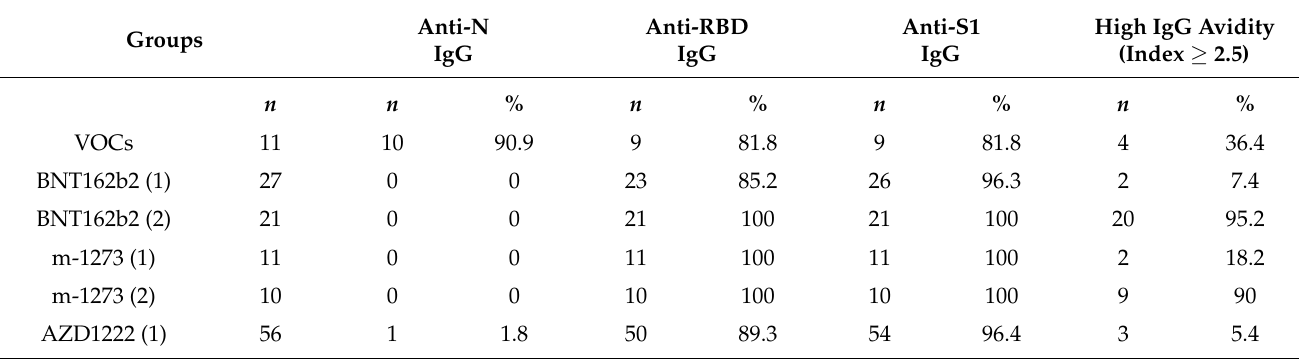
Table 2. Pattern of Immunoglobulin G (IgG) reactivity and avidity in patients after infection with SARS-CoV-2 variants of concern (VOCs) or after first (1) and second (2) immunization with messenger ribonucleic acid (BNT162b2; mRNA-1273) or vector (AZD1222)